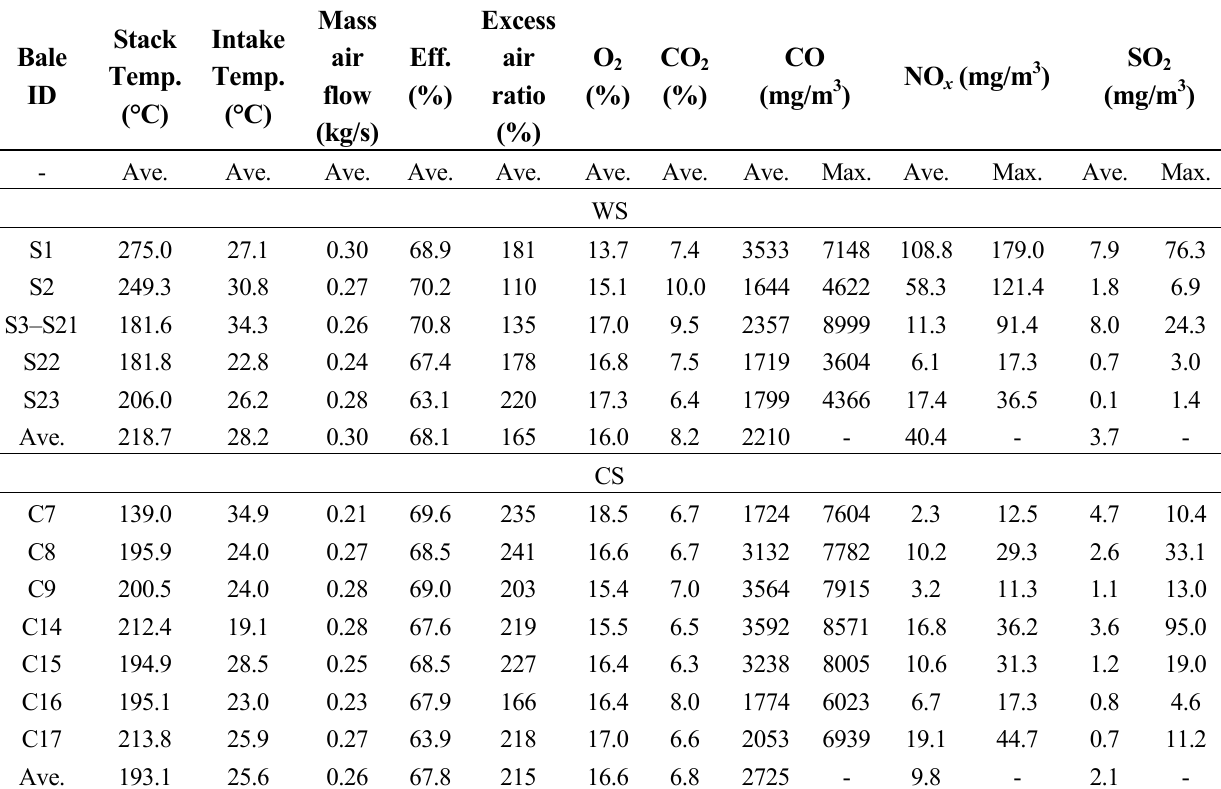
Table 4. Flue gas emission measurements for WS and CS bale